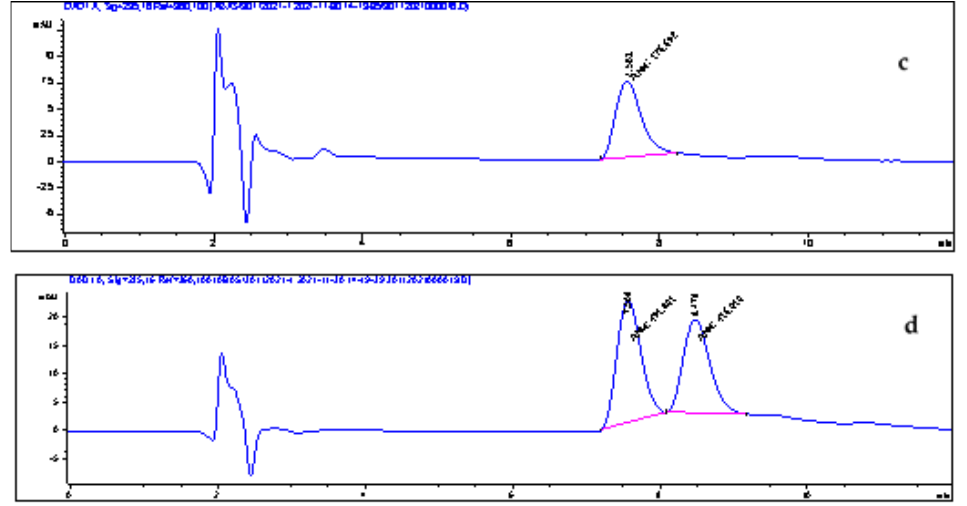
Figure 12. Chromatograms of the soft drink sample ( c ) and the soft drink sample spiked with 5 µg mL −1 of BA and SA ( d ). Benzoic acid: 7.5 min; sorbic acid: 8.4 min.